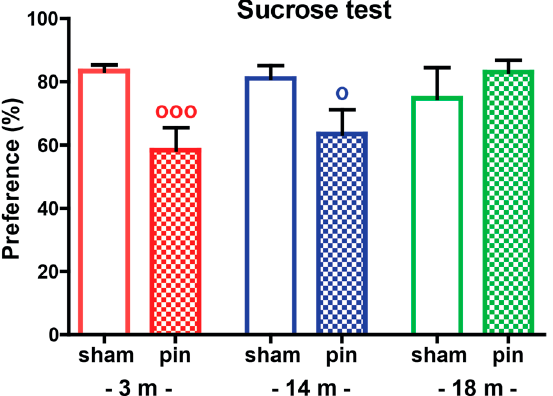
Figure 3. The effect of pin on preference to drink sweet solutions (anhedonia) of 3-, 14- and 18-month- old rats tested in the sucrose preference test. Data are presented as mean ± S.E.M. ooo p = 0.001, 3-month-old pin compared to matched sham group; o p = 0.021, 14-month-old pin compared to matched sham group. 3-month-old rats—red; 14-month-old rats—blue; 18-month-old